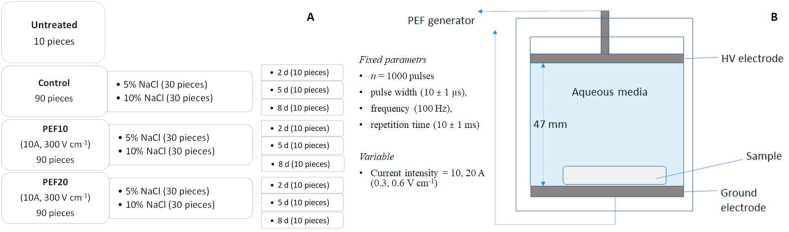
Flow chart of the process (A) and schematic representation of the treatment chamber (B).